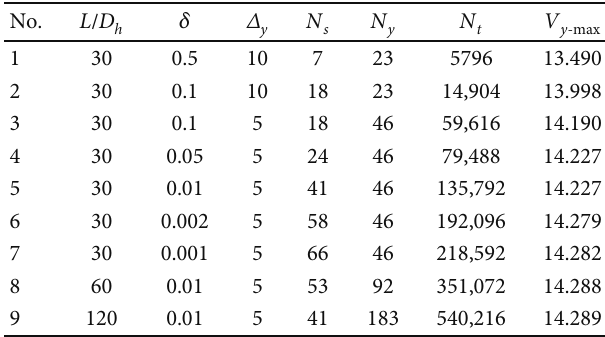
. h Table 1: Irrelevance veri fi cations for both the grid size and the axial computational